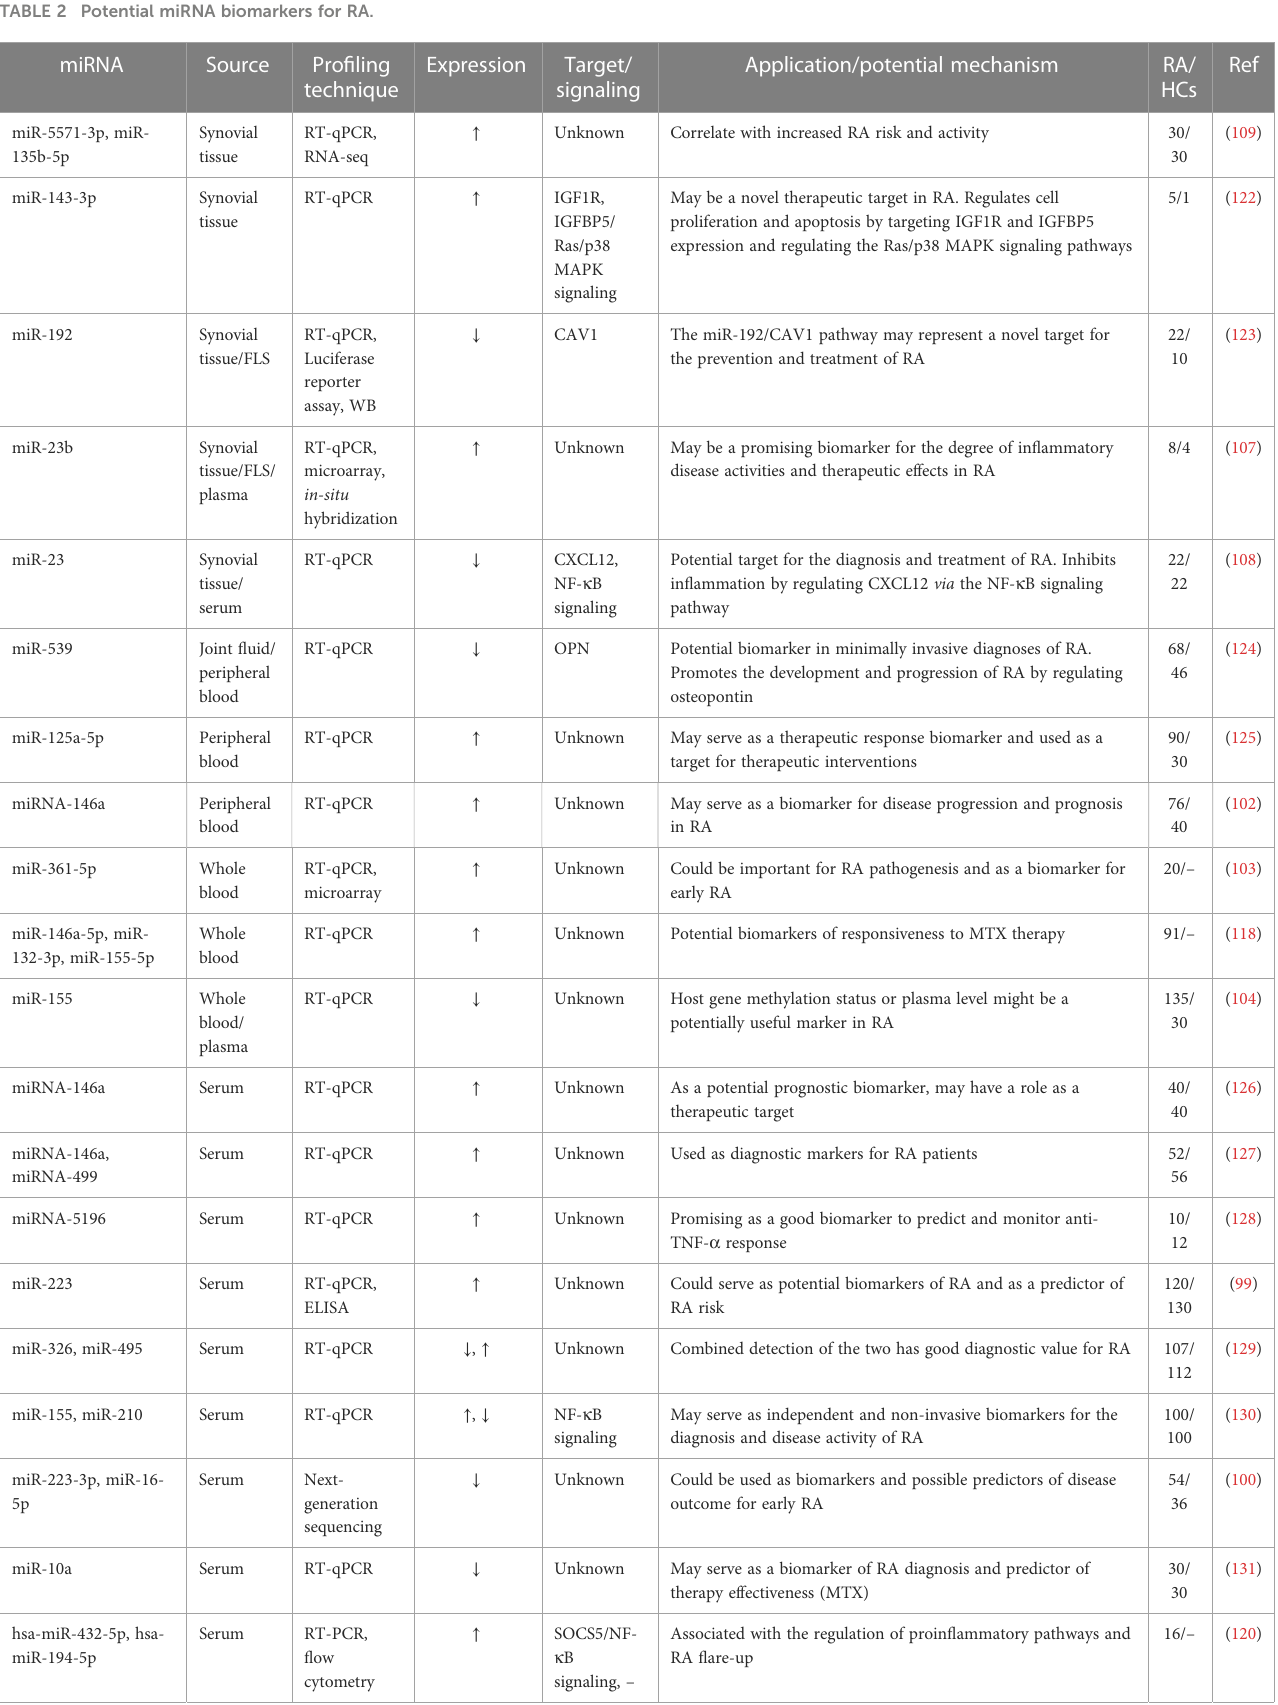
TABLE 2 Potential miRNA biomarkers for